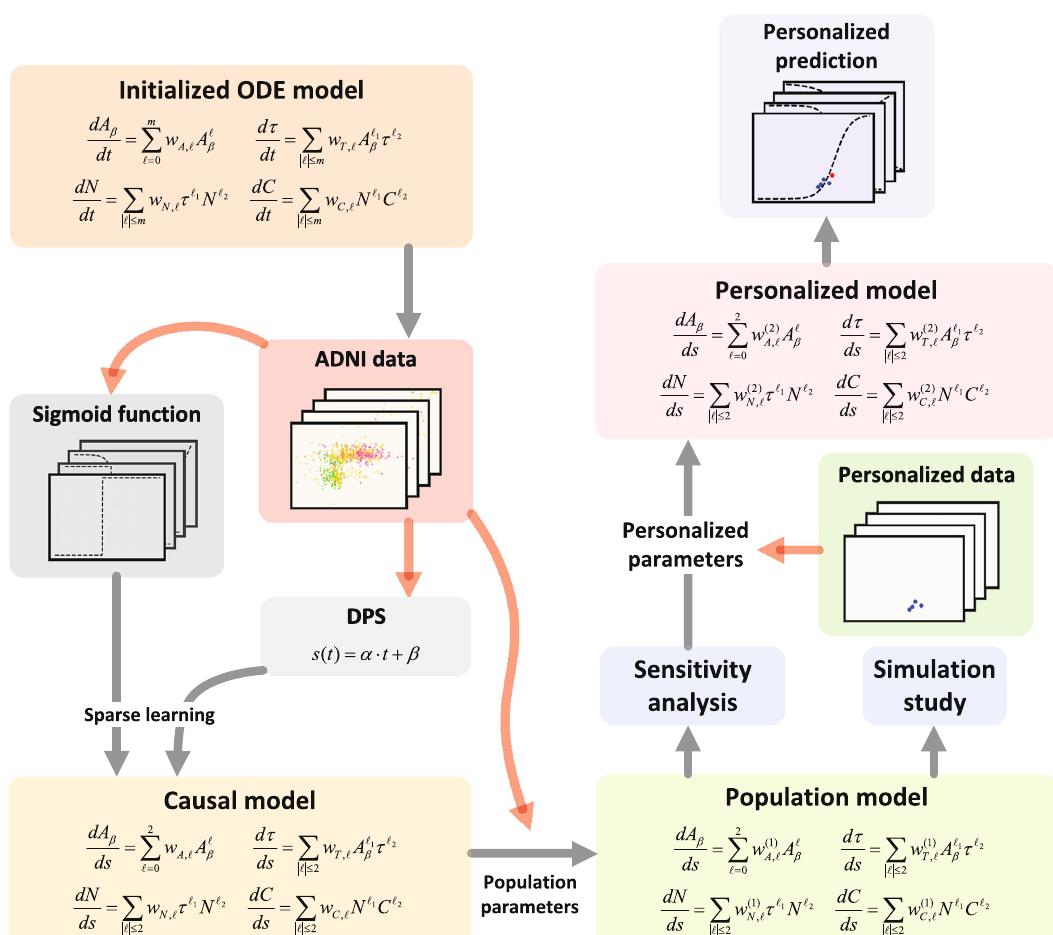
Fig. 5 A fl owchart of the pathophysiology and data-driven modeling approach. Given the initialized ODE model, a causal model is obtained by fi tting the ADNI dataset and DPS model through sparse learning; secondly, the ADNI dataset is used to calibrate the population parameters in the causal model and obtain the population model; thirdly, a sensitivity analysis is applied to analyze the sensitivity of each population parameters and determine the sensitive personalized parameters, and a simulate study is conducted to validate the population model. Then, the personalized model is obtained by calibrating the sensitive personalized parameters with the use of personalized data. A prediction is made by the personalized model in the